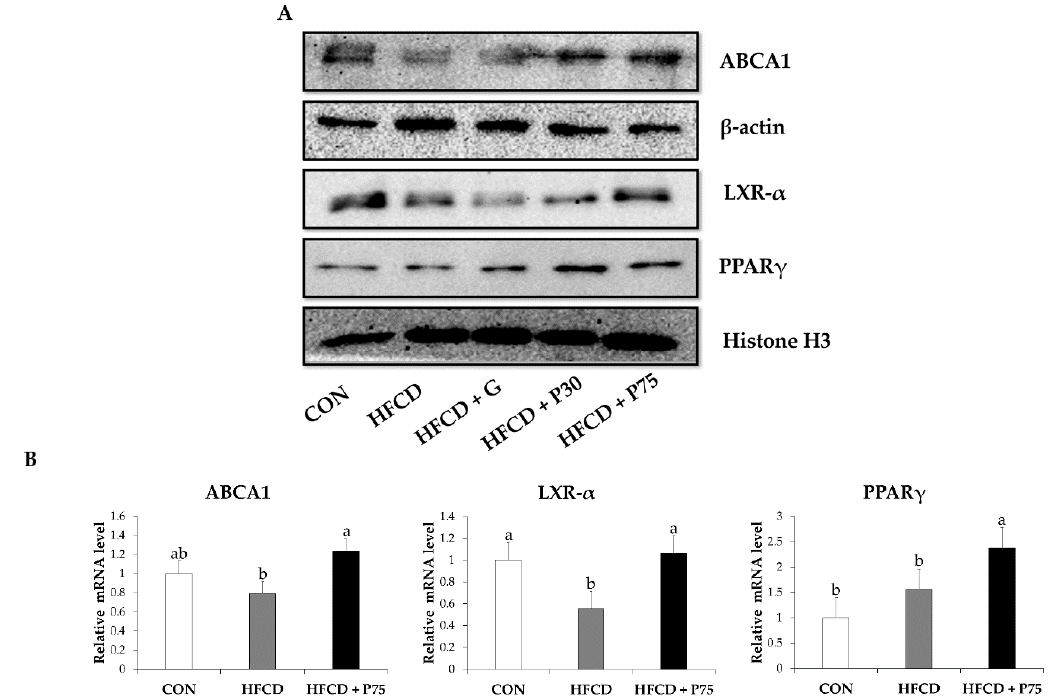
Figure 3. PEITC regulates the reverse cholesterol transport pathway in the livers of HFCD-fed mice: ( A ) Immunoblotting was used to measure the protein levels of ATP binding cassette subfamily A member 1(ABCA1), liver-X-receptor α (LXR- α ), and peroxisome proliferator activated receptor gamma (PPAR γ ). Equal loading of protein was ensured by stripping the immunoblot and reprobing for β -actin and histone H3; ( B ) Evaluated mRNA levels of ABCA1, LXR- α , and PPAR γ in mice liver. Values were analyzed by the 2 − ∆∆ CT method. Significance was determined by comparison with β -actin normalized 2 − ∆∆ CT values. Data represent the means ± standard deviation (SD, n = 3, degrees of freedom = 2), and di ff erent letters indicate significant di ff erences ( p < 0.05, a > b), as determined using Duncan’s multiple range test. CON: AIN-93G diet, HFCD: 60% calories from fat + 1% cholesterol, HFCD + G: HFCD + 3 mg / kg / day GA, HFCD + P30: HFCD + 30 mg / kg / day PEITC, HFCD + P75: HFCD + 75 mg / kg / day